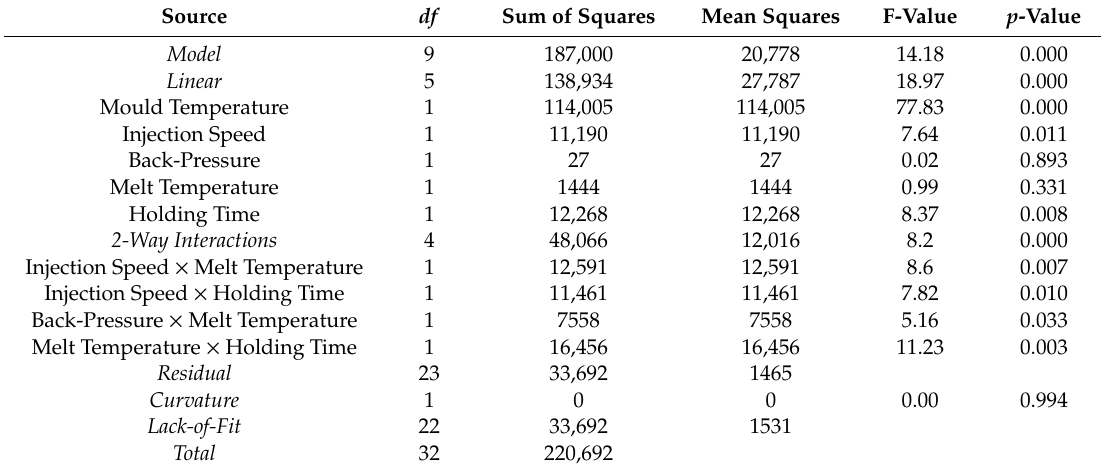
Table 2. Analysis of variance model for Young’s modulus against processing